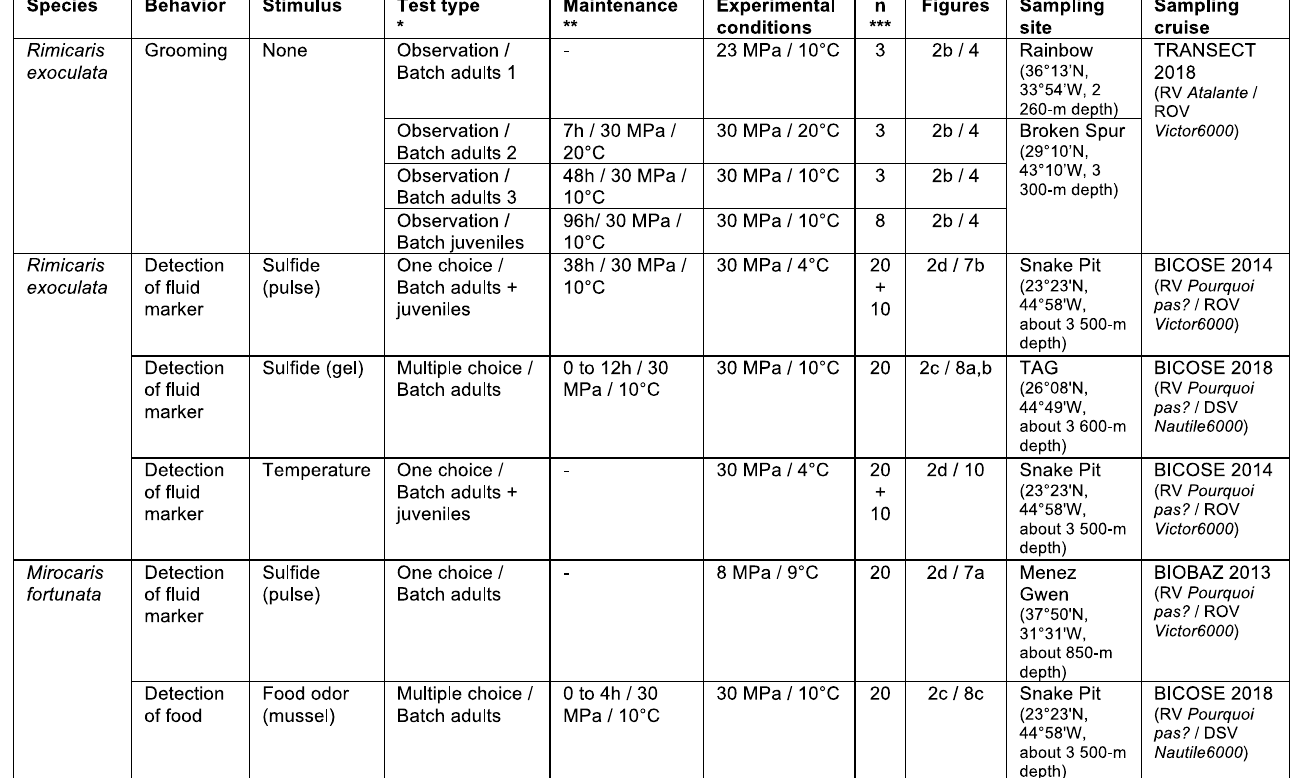
Figure 2. Species collection and experimental condition for behavioral experiments at in situ pressure. * Type of test applied either to a batch of shrimp or to single specimens; ** duration and condition of maintenance in pressurized aquaria before the experiment; *** number of shrimp for each experiment (some experiments were performed several times, see figure legends for more information).